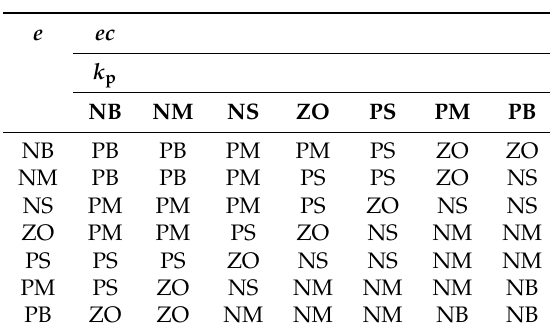
Table 3. Fuzzy rule k p